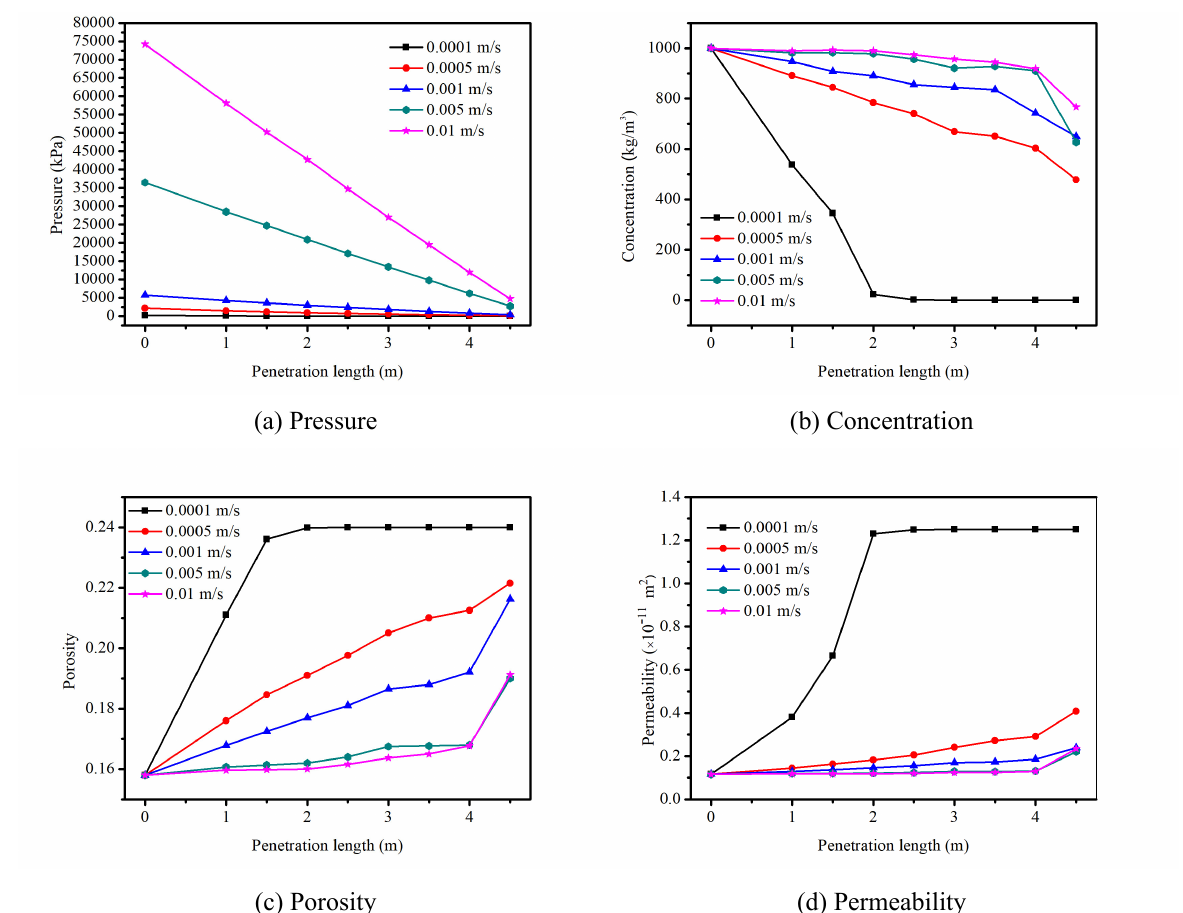
Figure 8. Influences of the injection velocity on the pore pressure, concentration, porosity and